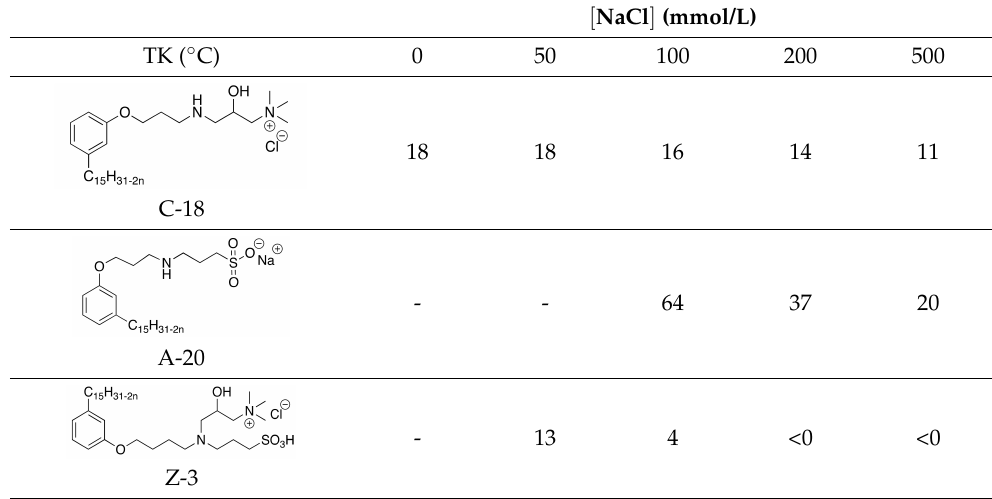
Table 1. Influence of salt on Kraft temperature of ionic CNSL-based surfactants